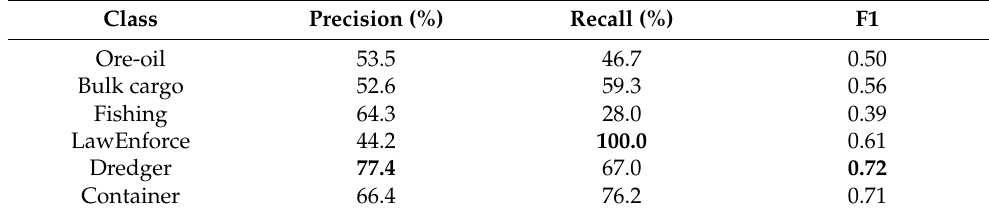
Table 7. Detection results of six categories of